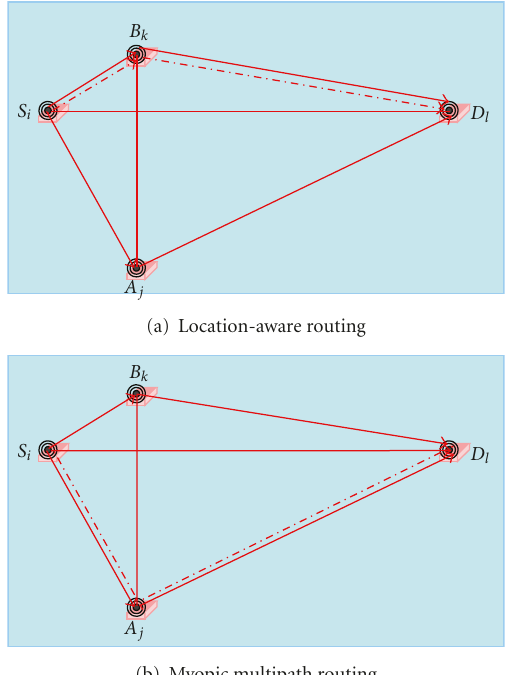
Figure 2: Energy-aware